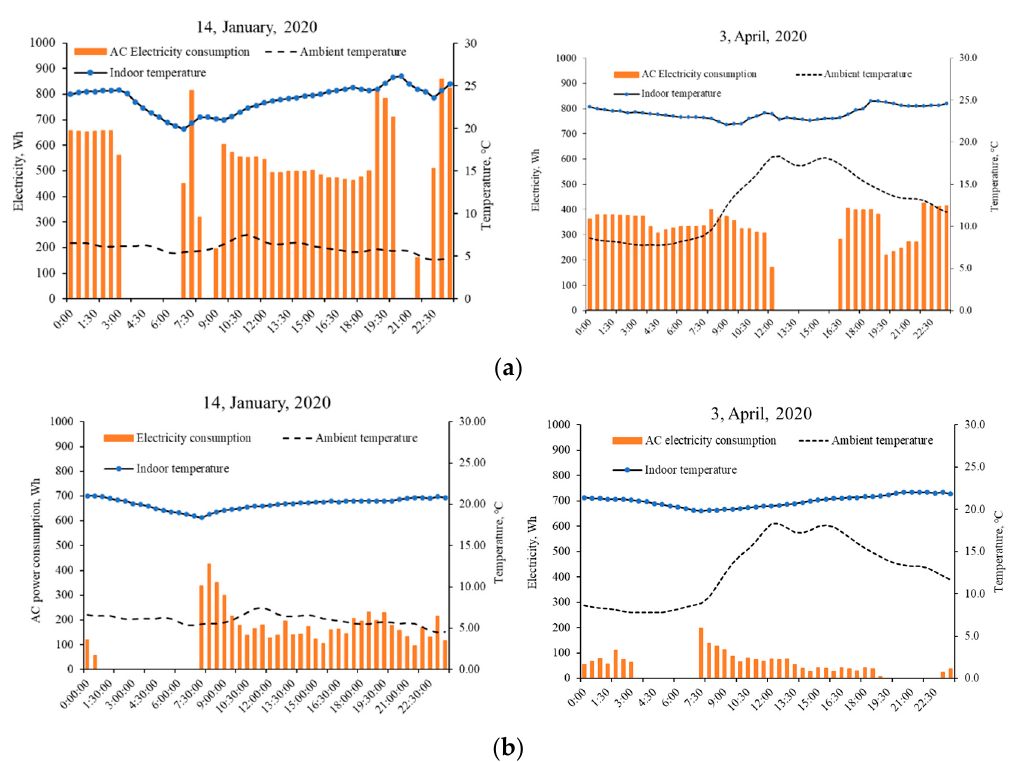
Figure 5. Variations of measured daily room air temperature, ambient air temperature, and corresponding air conditioner electricity consumption profiles of ZEH 1 ( a ) and ZEH 2 ( b ).